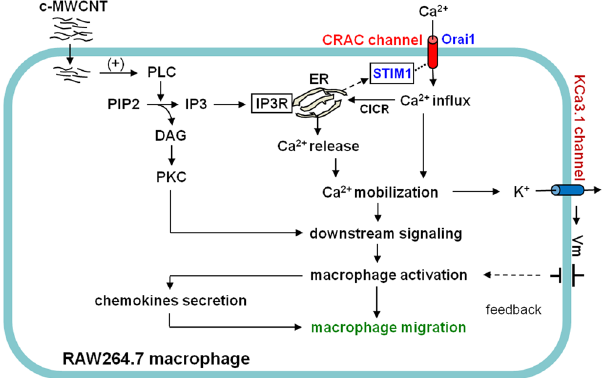
Figure 7. Schematic representation of the putative signaling pathways underlying the migration-stimulating effect of c-MWCNTs on RAW264.7 macrophages based on the present study and related reports. The c-MWCNTs are internalized and act intracellularly. After entering the cells, c-MWCNTs first activate PLC, leading to hydrolysis of PIP2 and production of IP3 and diacyl glycerol (DAG). IP3 triggers calcium release via the Ca 2 + -releasing channel IP3 receptor (IP3R) and leads to depletion of the endoplasmic reticulum (ER). The ER-resident STIM1 senses ER depletion and translocates to the ER-PM junctions and thus activates the Orai1 calcium channel and generates CRAC current (Ca 2 + influx). Ca 2 + influx, together with Ca 2 + release, triggers the downstream signaling cascades responsible for macrophage activation and migration. Activated RAW264.7 macrophages release cytokines including chemokines, further stimulating macrophage migration. In addition, the KCa3.1 channel is activated by [Ca 2 + ] i elevation and mediates K + efflux, thus resulting in repolarization of the membrane potential (V m ) and providing a feedback signal to the activated